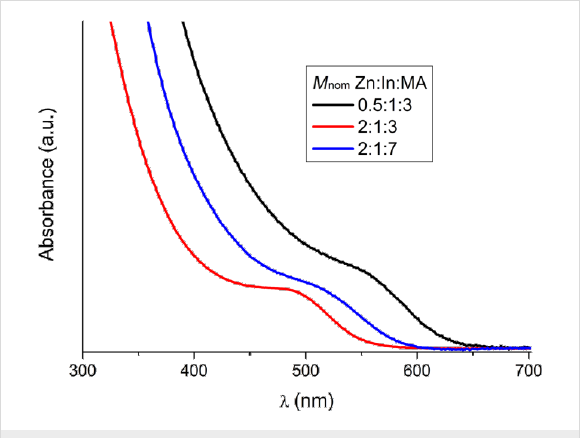
Figure 1: UV–vis absorption spectra of Zn-doped InP